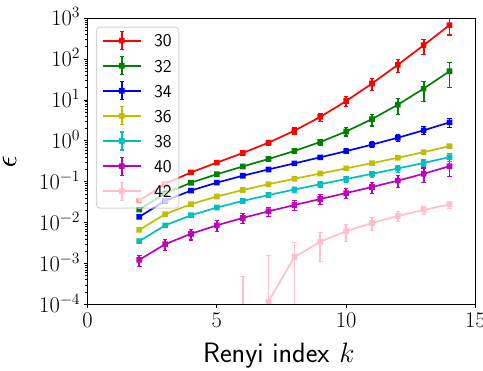
FIG. 10. The design-error from measurements of the Renyi entanglement. We estimate (cid:12) using Eq. (A5). At large Renyi index k it becomes harder to achieve maximum